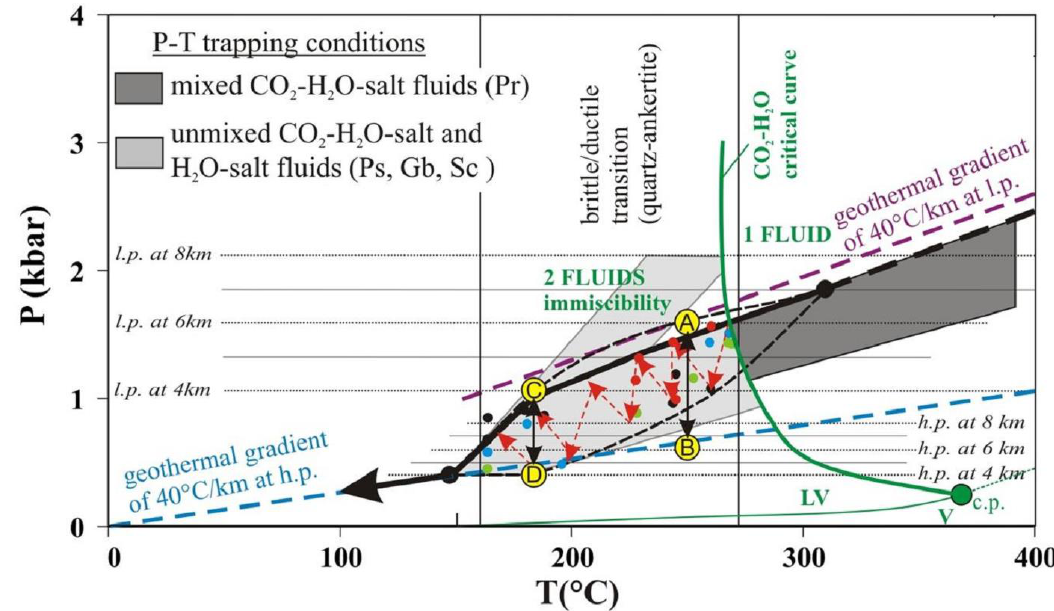
Figure 10. Schematic illustration of the inferred P-T fluid circulation pathway during formation of the El Callao vein system. The black arrow indicates the suggested P-T pathway during vein mesh development. The dashed curved black line indicates the range of pressure fluctuations (red dashed arrows) within the transition from a lithostatic (calculated for an average rock density of 2.7 g/cm 3 ) to a hydrostatic pressure regime. The critical curve is illustrated for a salt-free composition. Green dots: neonate fluid inclusions, blue dots: pseudosecondary fluid inclusions, red dots: grain boundary fluid inclusions and black dots: secondary fluid inclusions.